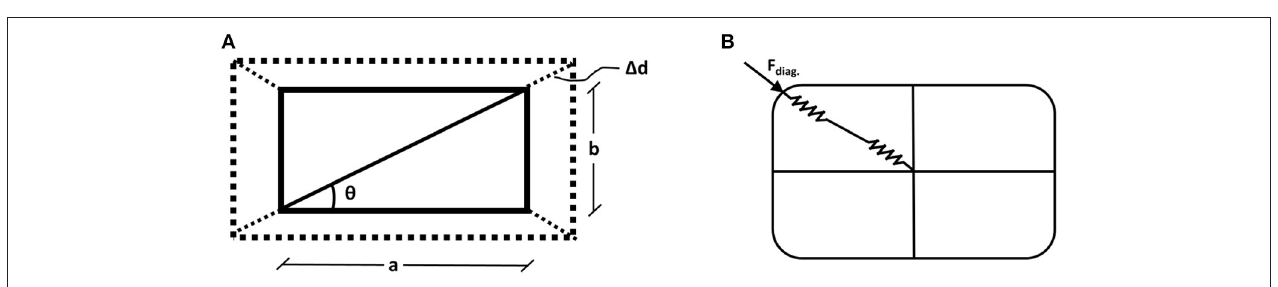
FIGURE 8 | (A) Deformed shape of a rectangular section based only on the diagonal lateral deformation, (B) Diagonal force applied to the lateral springs from the corner.